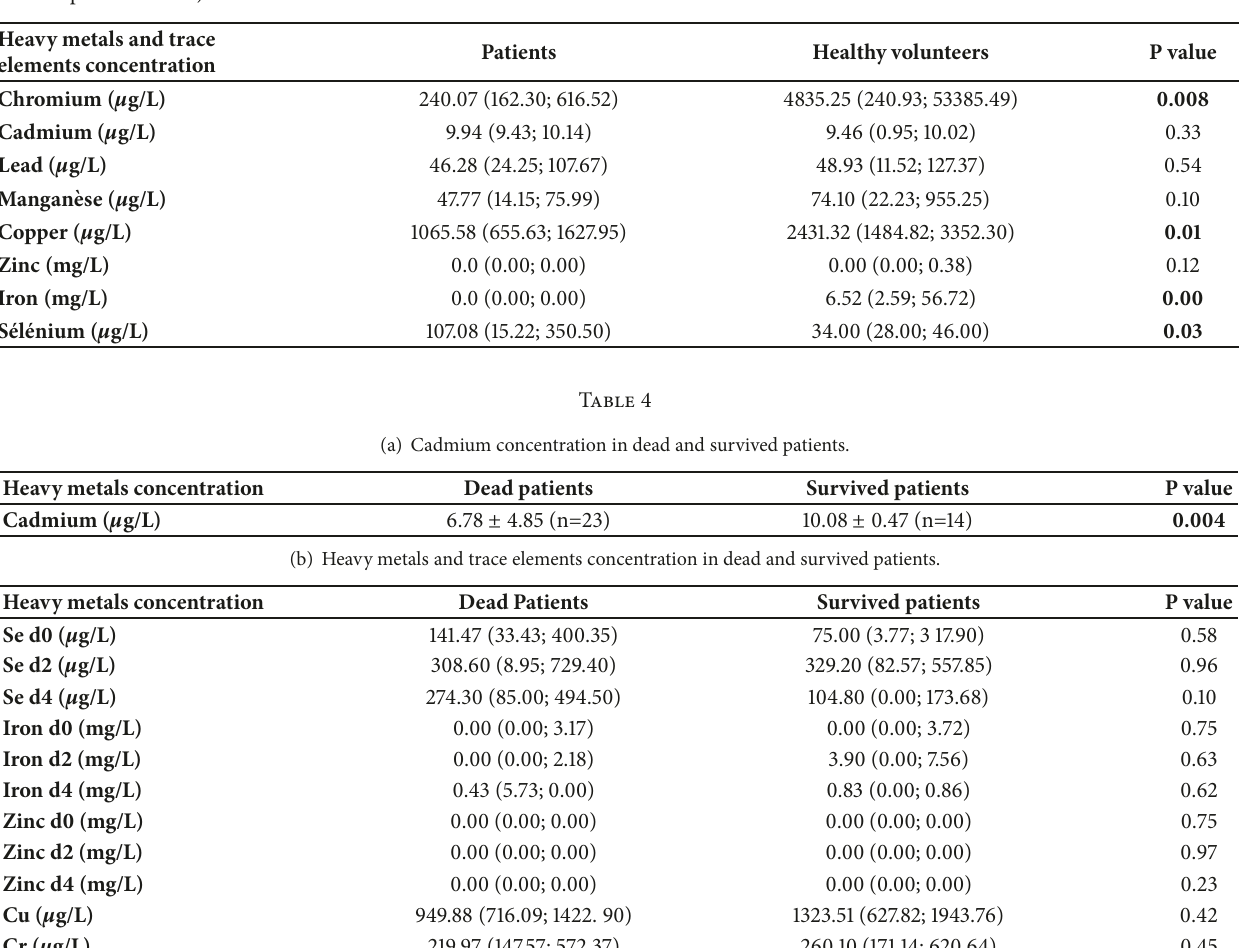
Table 3: Heavy metals and trace elements concentration in patients and healthy volunteers (Cr, Cd, Pb, Mn, Cu,, the data show an average over the period of 48H).